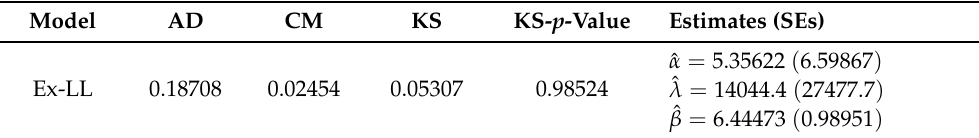
Table 14. Measures of goodness-of-fit and estimates of the Ex-LL distribution and other distributions for data set